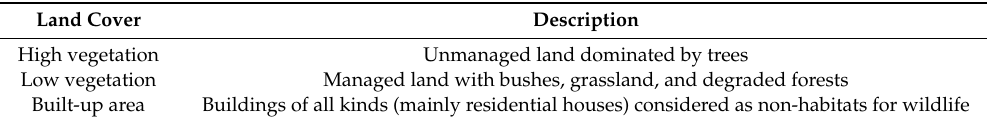
Table 1. Land-use and land-cover classification of the study